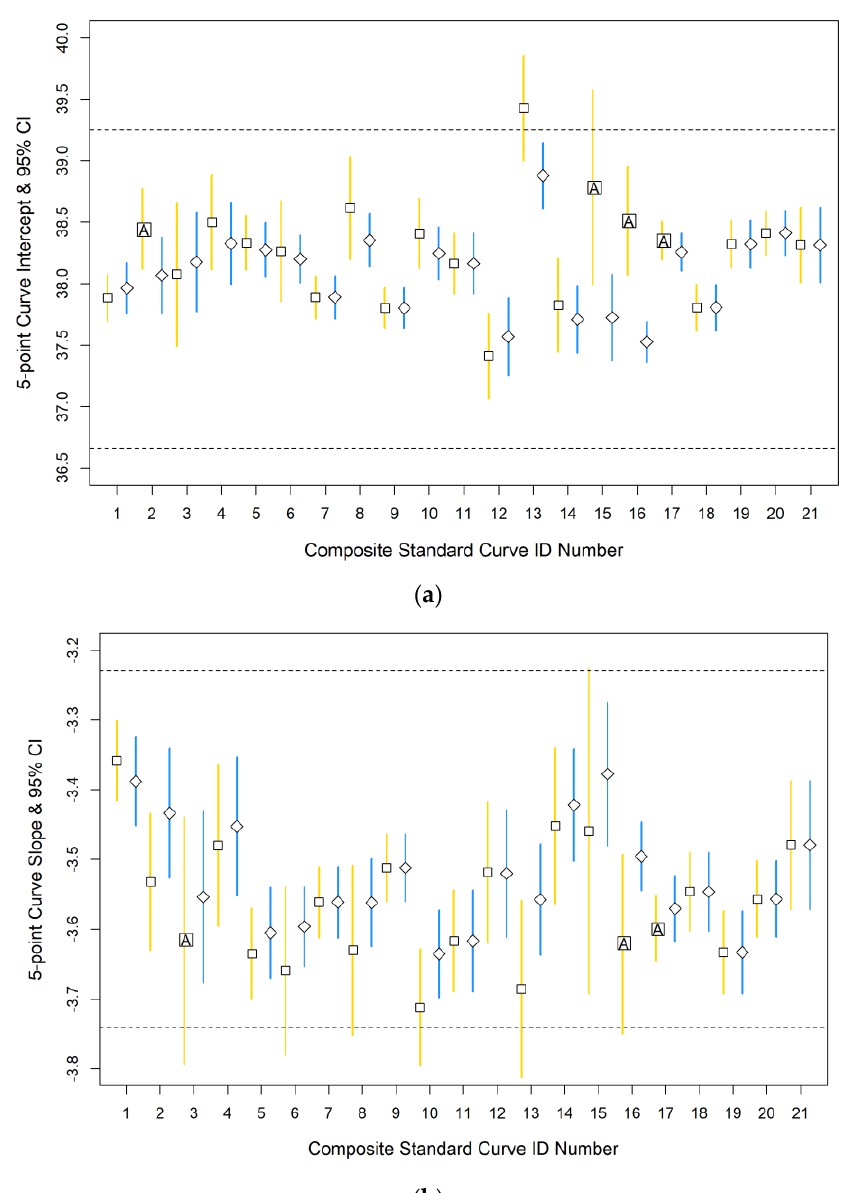
Figure 3. Mean 5-point composite standard curves intercept and slope estimates and 95 % confidence intervals (CIs). ( a ) Mean intercept; and ( b ) mean slope estimates before (open squares with gold lines) and after (open diamonds with blue lines) data screening with the proposed acceptance criteria. Vertical lines represent 95% CIs. Horizontal dashed lines represent the standard curve acceptance criteria range. Boxes with an inset “A” show individual standard curves without acceptance criteria enforced that did not pass the analysis of covariance (ANCOVA) therefore a composite curve value was not calculated in the Excel workbook.